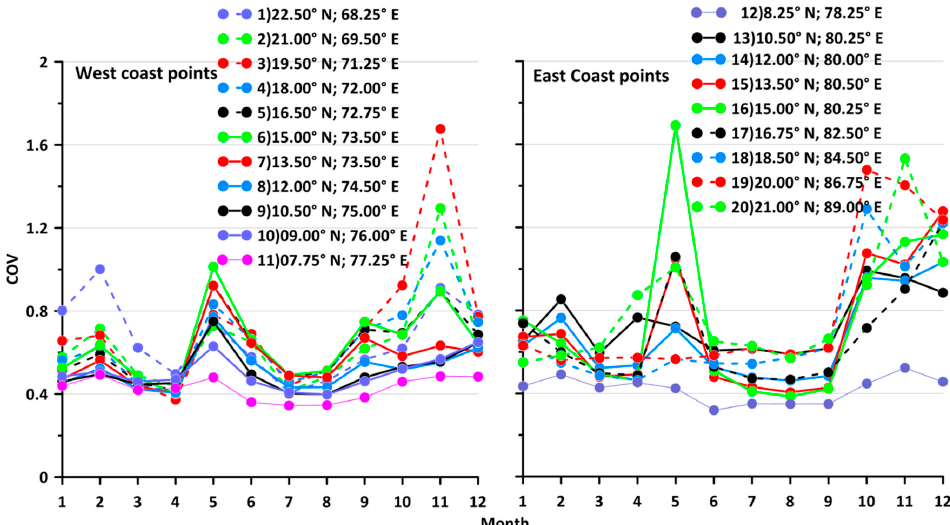
Figure 7. Monthly coefficient of variation (COV) values at different locations. Left panel is for locations in the western shelf seas of India and the right panel is for the eastern shelf seas.